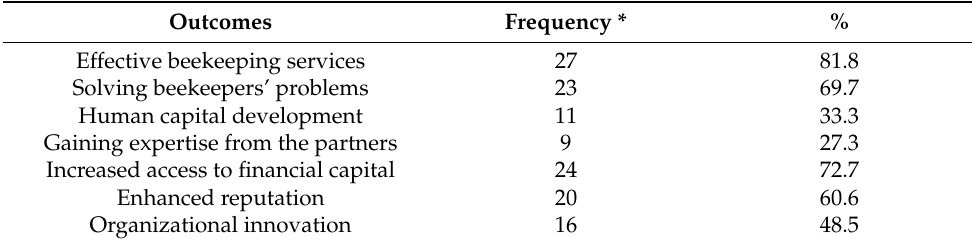
Table 12. Outcomes of the